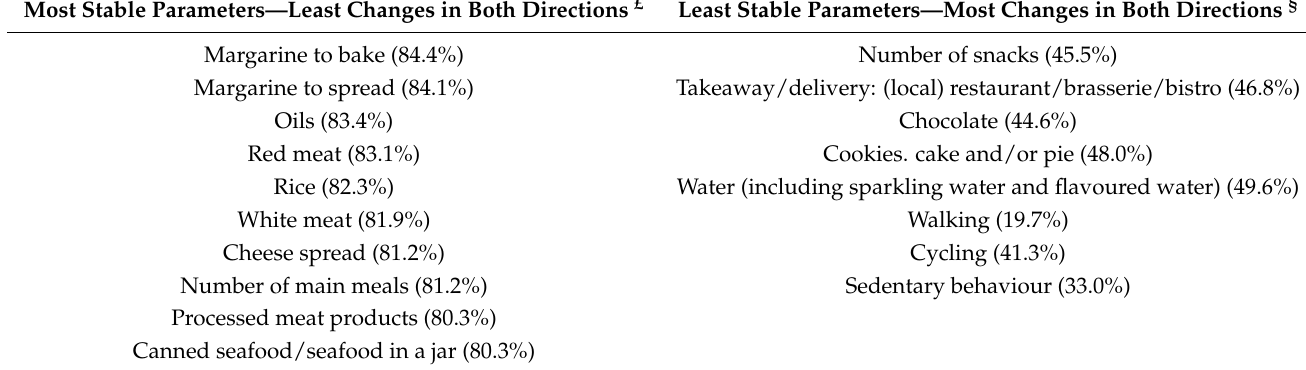
Table 3. Most stable and least stable parameters (in percentages of score 3 (=“I consume/do this now the same as before the